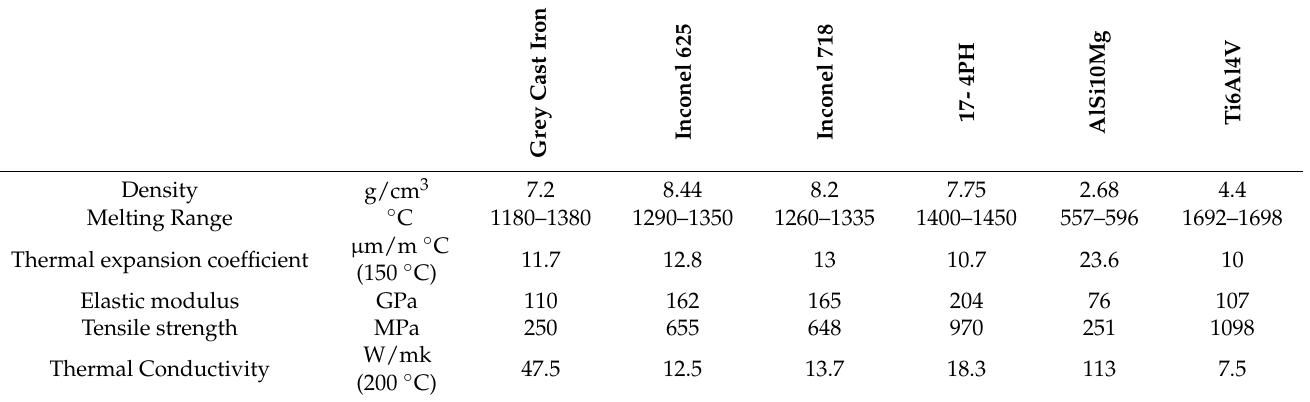
Table 1. Properties of AM materials vs. grey cast iron [36–39].